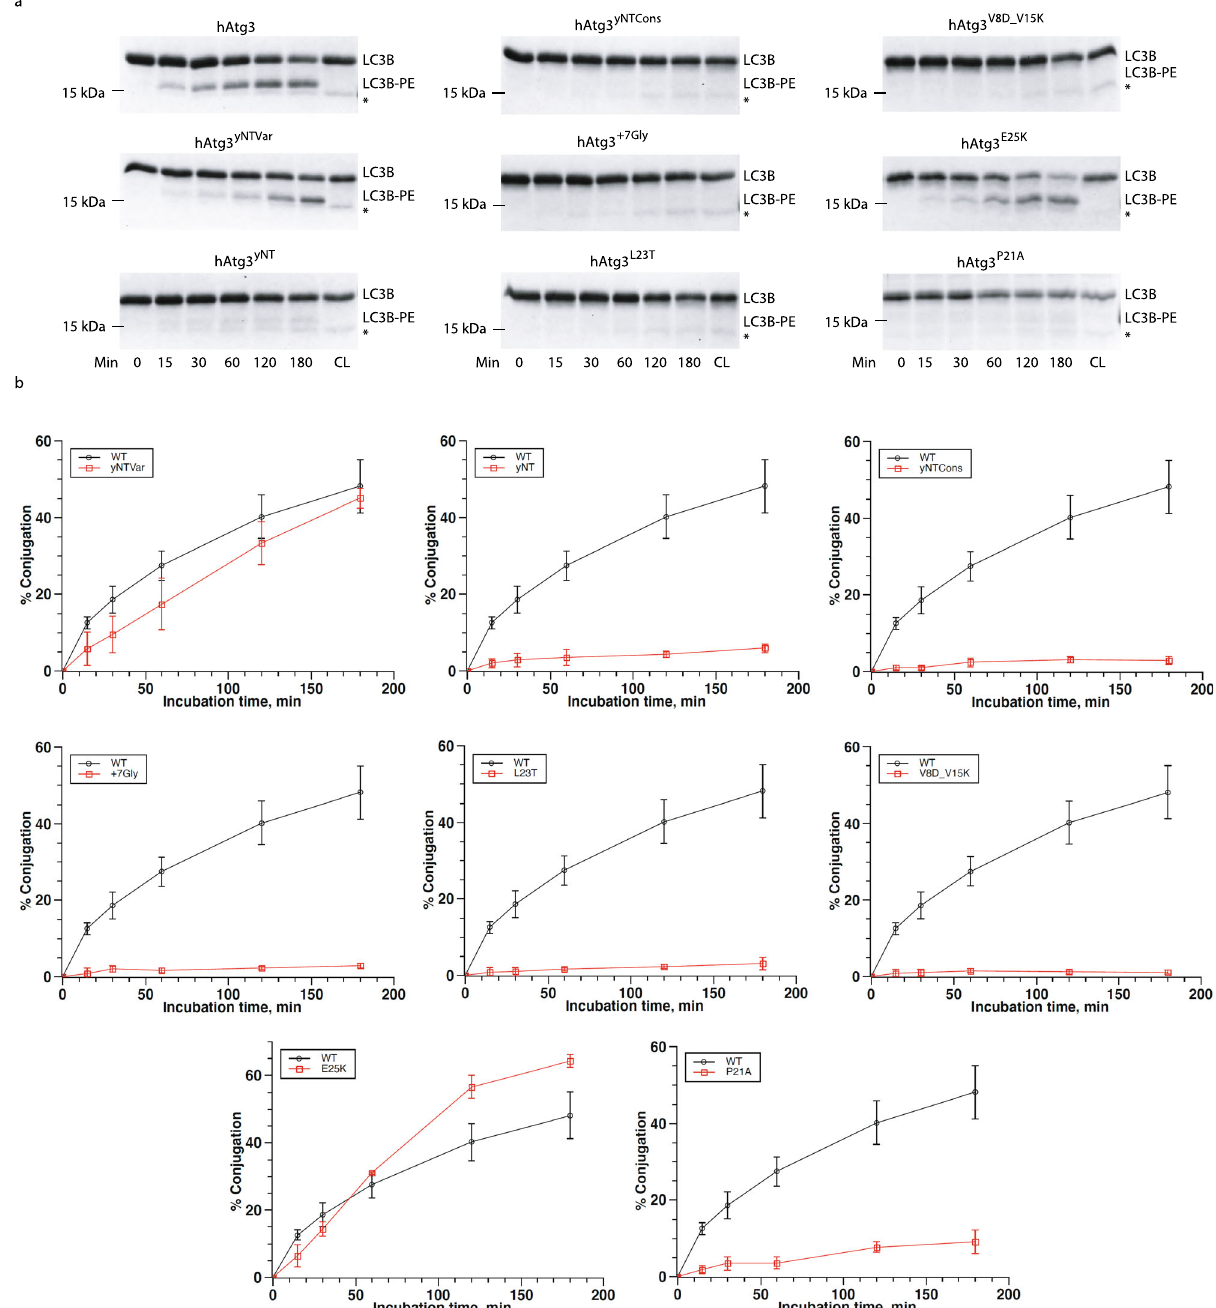
Fig. 3 The N-terminal conserved region of hAtg3 is critical for protein function. a SDS-PAGE gel images of time-dependent formation of LC3B – PE for hAtg3, hAtg3 yNTVar , hAtg3 yNT , hAtg3 yNTCons , hAtg + 7Gly , and for hAtg3 P21A , hAtg3 L23T , hAtg3 E25K as well as hAtg3 V8D_V15K . Gels were quanti fi ed with ImageJ; conjugation percentage of LC3B – PE was determined by the amount of LC3B – PE divided by the total LC3B present. CL is the control without liposomes. * Asterisk indicates a small amount of degradation of LC3B in the presence of ATP. b Plots of time-dependent formation of LC3B – PE for hAtg3 and mutants. Data are presented as mean ± SD. Quanti fi cation of conjugation reactions were obtained from three separate measurements ( n =